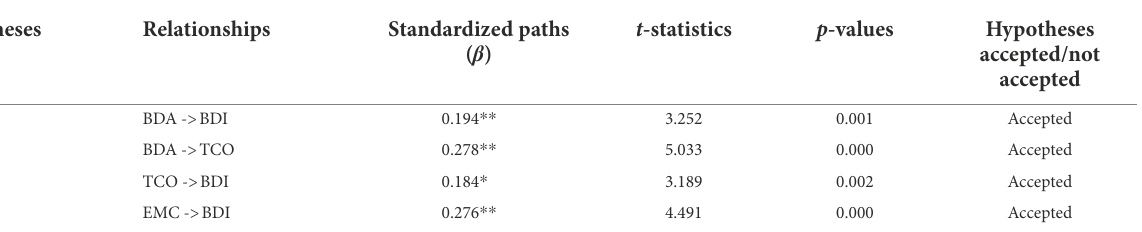
TABLE 5 Structural model estimates.